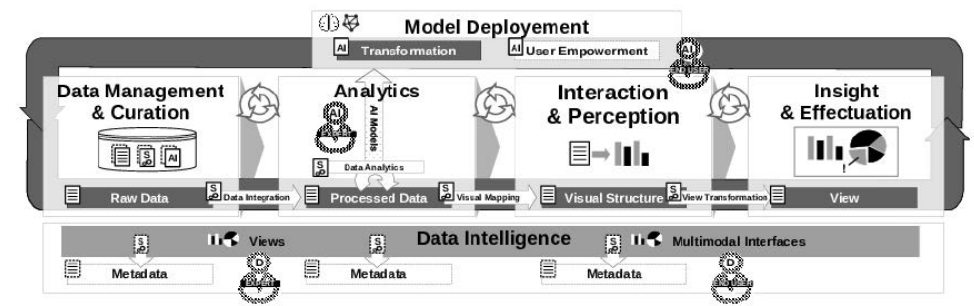
Figure 6. AI2VIS4BigData reference model, © 2022 IEEE reprinted, with permission, from Reis et al.